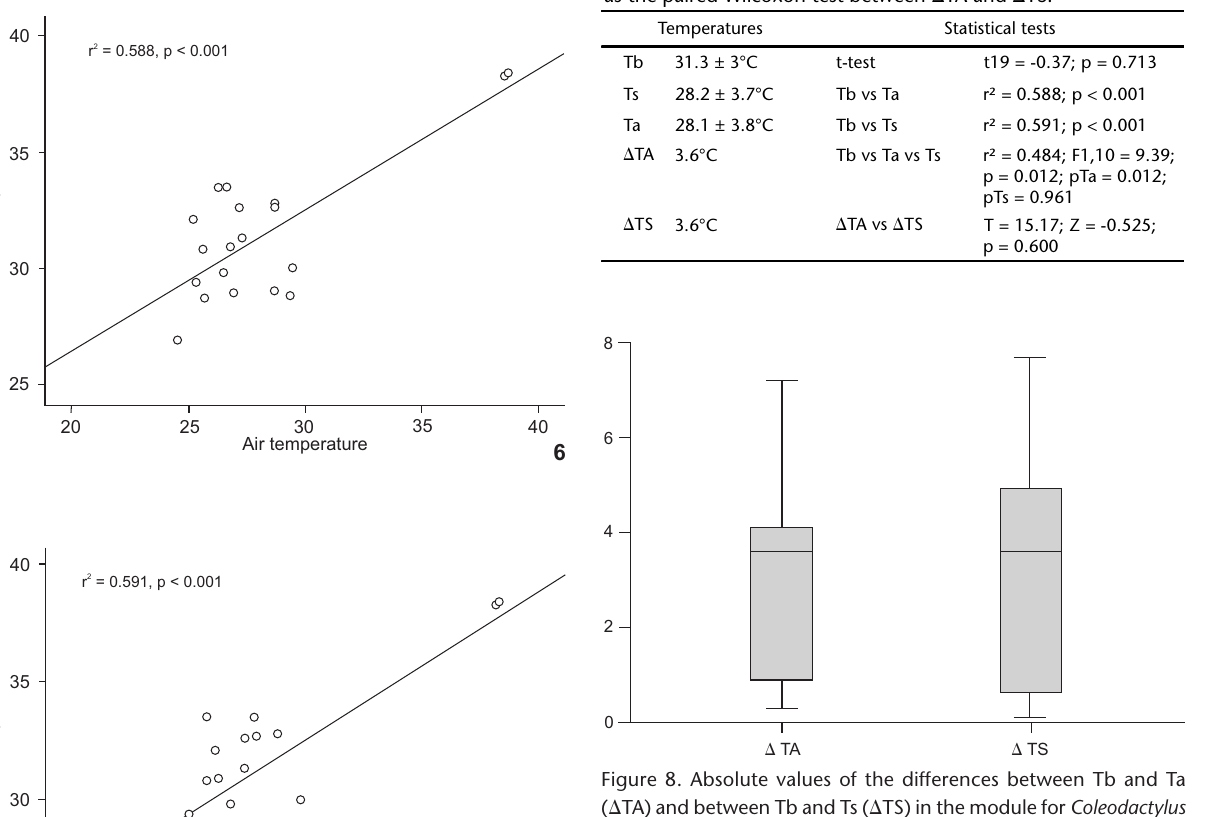
Figure 8. Absolute values of the differences between Tb and Ta ( (cid:2) TA) and between Tb and Ts ( (cid:2) TS) in the module for Coleodactylus natalensis (N = 20) in Parque Estadual Mata da Pipa, Tibau do Sul, Rio Grande do Norte,